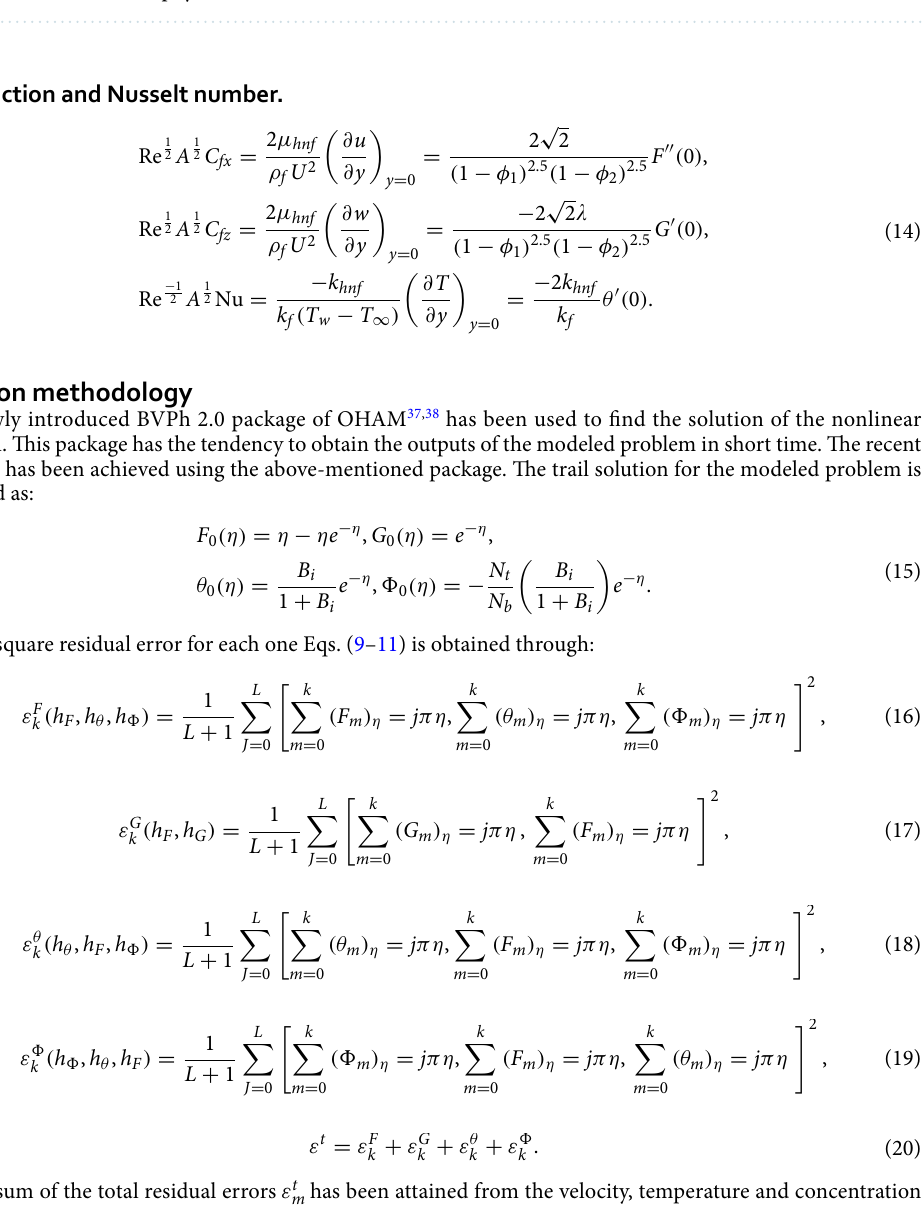
Table 3. Various thermo-physical characters of blood, Silver and Titania 36 .